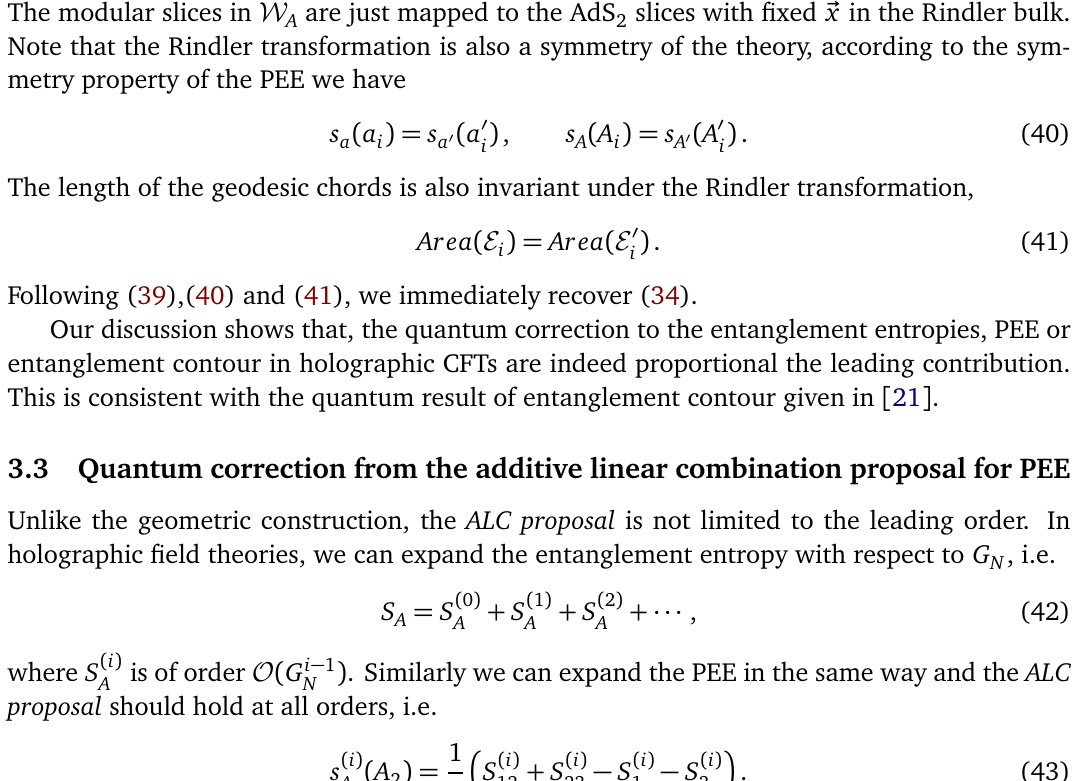
curves are mapped to the curves P is just mapped to the bulk region a (cid:48) , which 2 2 along the r 2